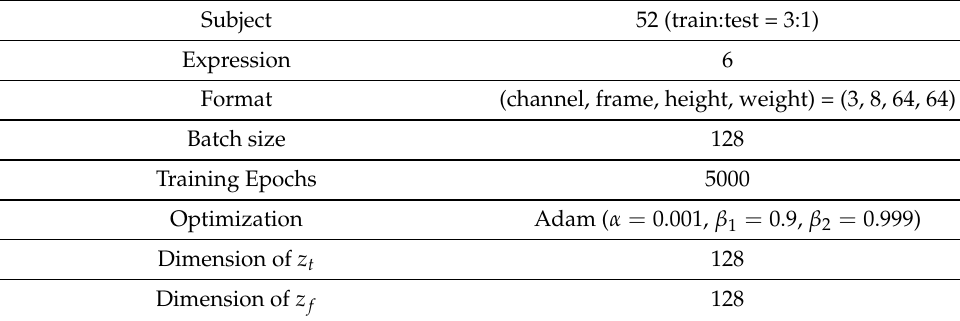
Table 2. Learning condition for the MUG